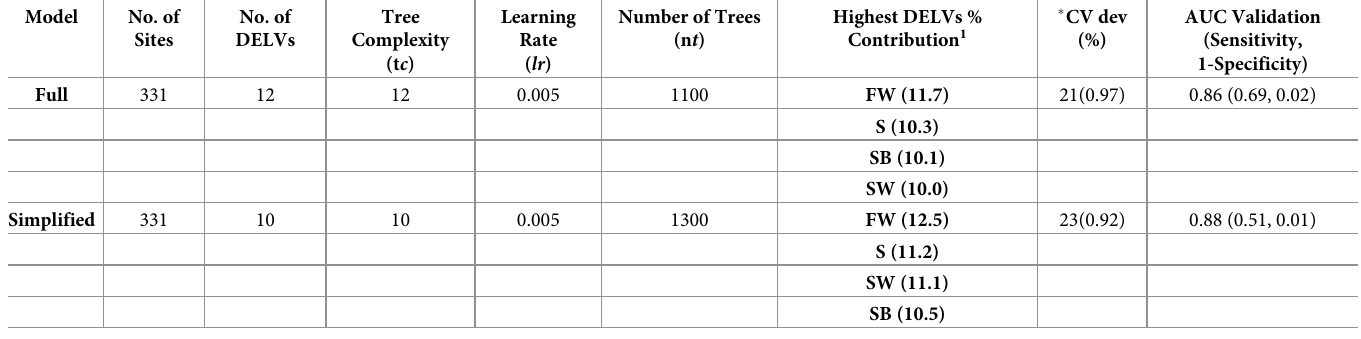
Table 3. Characteristics of the BRT Full and Simplified models and their predictive performance as evaluated on the test data, within a cross validation. Both mod- els developed with cross-validation on training data, learning rate of 0.005, using variables listed in Table 2.